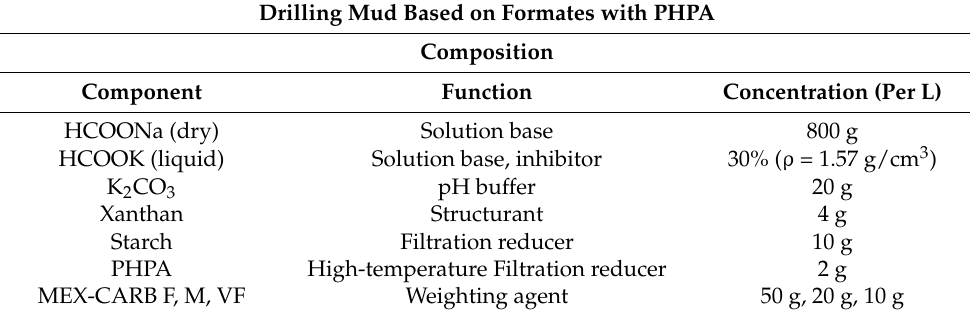
Table 2. Compositions and parameters of the investigated